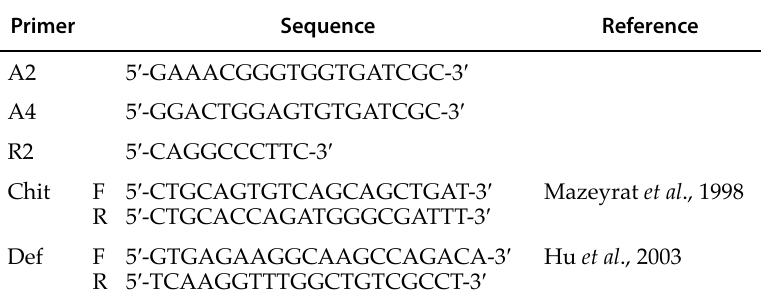
Table 1. Nucleotide sequence of the primers used for DD-PCR. Primer